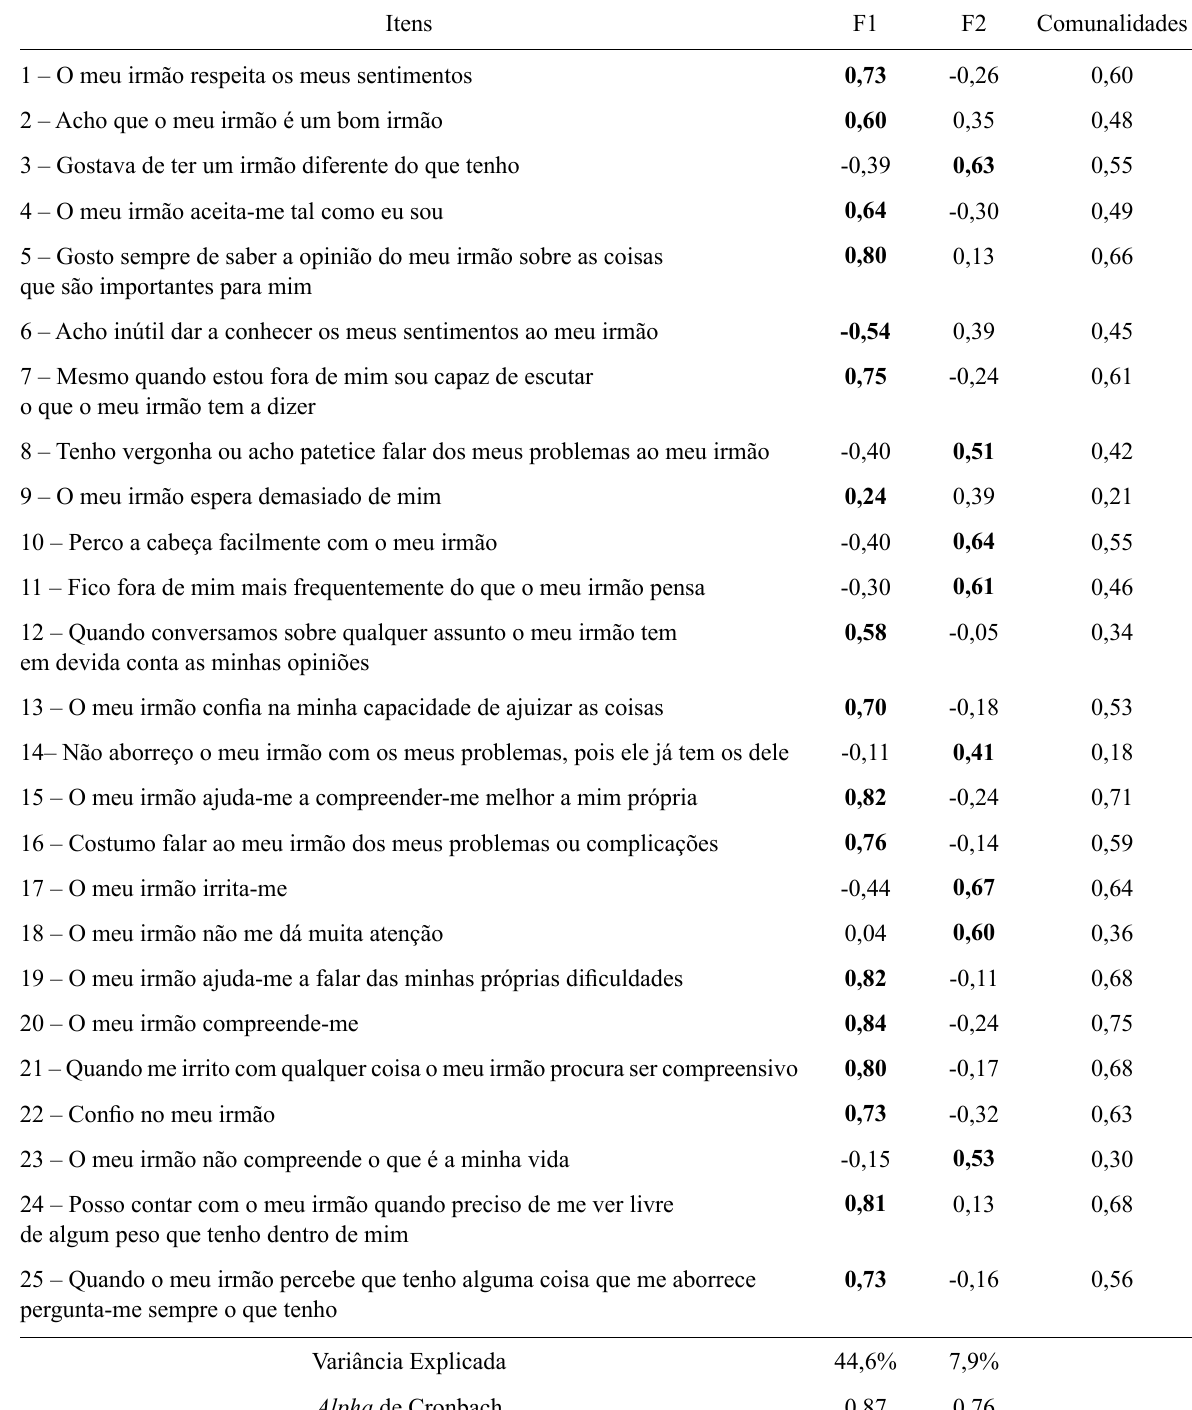
Loadings dos Itens nos Dois Factores, Comunalidades e Percentagem da Variância Explicada por Cada